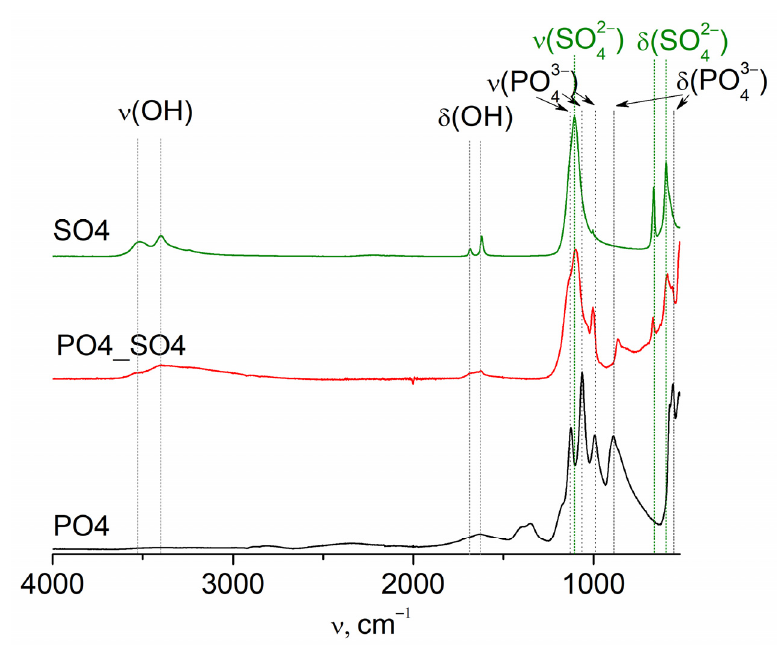
Figure 4. FTIR spectra of the samples after disaggregation in acetone.